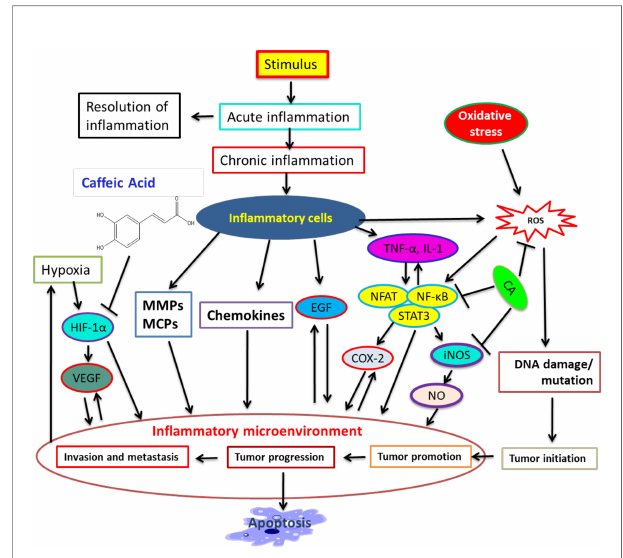
FIGURE 1 | A summary of connection among in fl ammation, cancer progression, and inhibitory action of CA. Many modulators involve in fl ammation in tumor progression. CA binds with modulators and represses cancer progression and stimulates apoptosis. [Adapted from Murtaza et al. (115) and Alam et al.